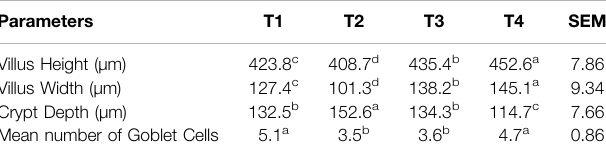
TABLE 6 | Morphometric analysis of ileum in the mice receiving different